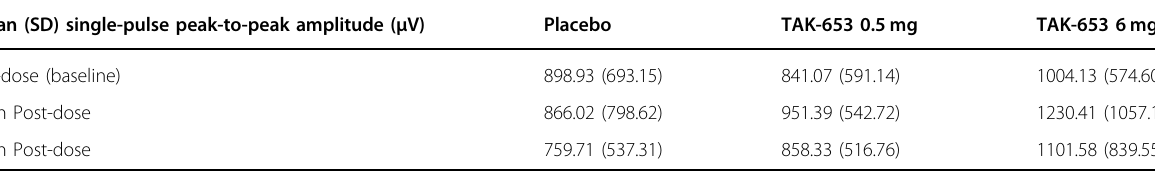
Table 4 Single-pulse peak-to-peak amplitude raw values. Mean (SD) single-pulse peak-to-peak amplitude